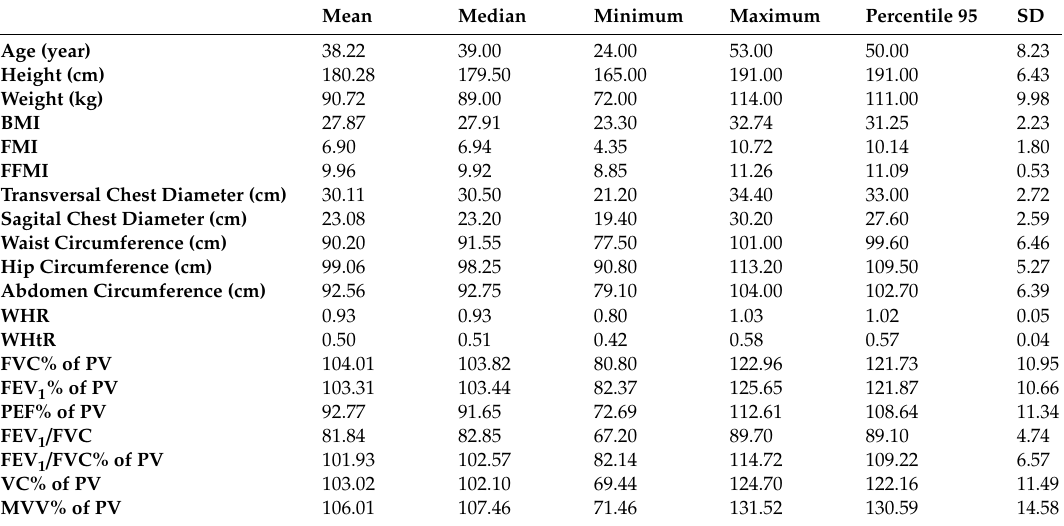
Table 2. Baseline characteristic of anthropometric and pulmonary function parameters. Mean